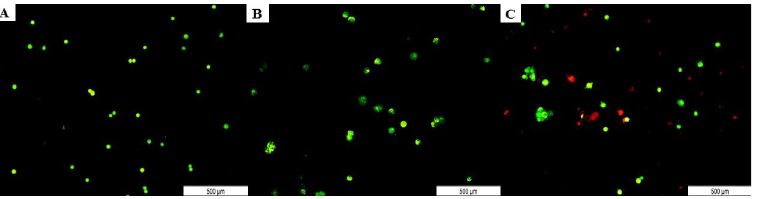
Fig 2. Microscopic observation of apoptosis in A549 cells 48 h post-transfection. AO/PI double staining was performed on non-transfected cells (A) and cells transfected with Hs.Cas9.MMP20.1.AA gRNA (B), and Hs.Cas9. MMP20.1.AA gRNA (C). All the images were taken with a magnification of × 400. Scale 500 μ m.